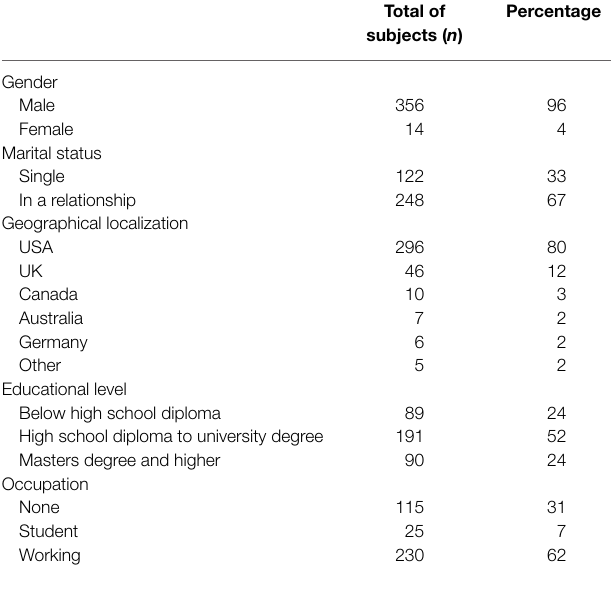
TABLE 2 | Sociodemographic characteristics of the study participants II